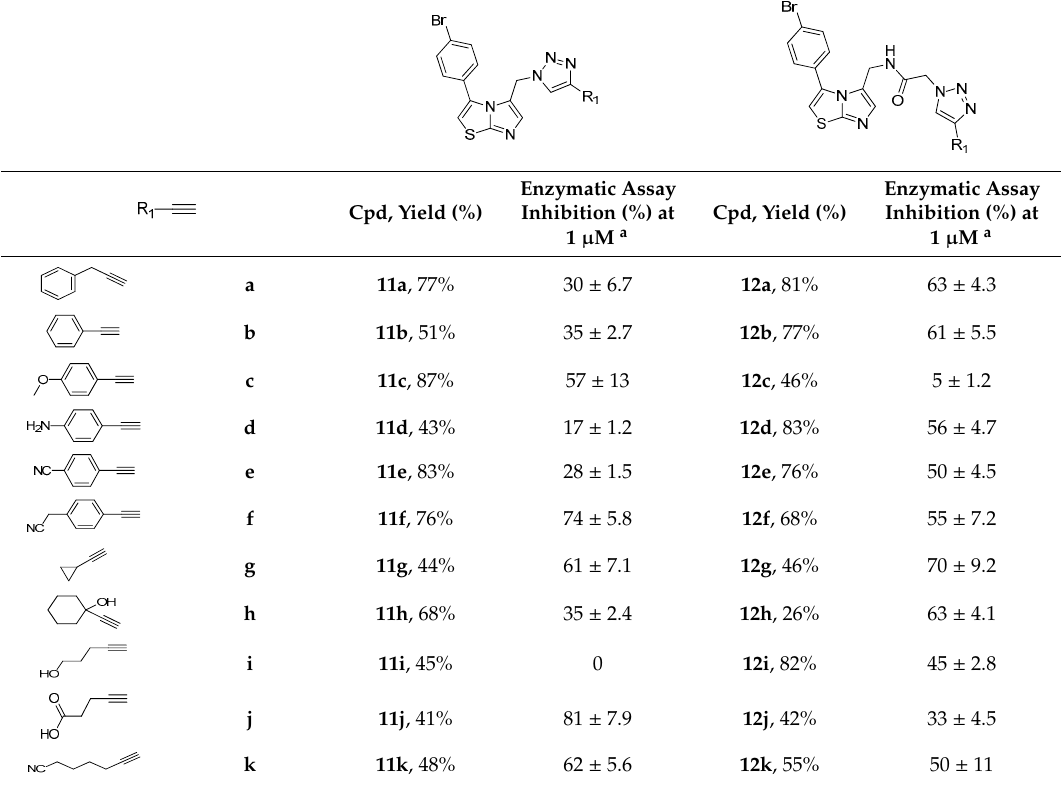
Table 1. Structure and biological profile of imidazothiazoles.